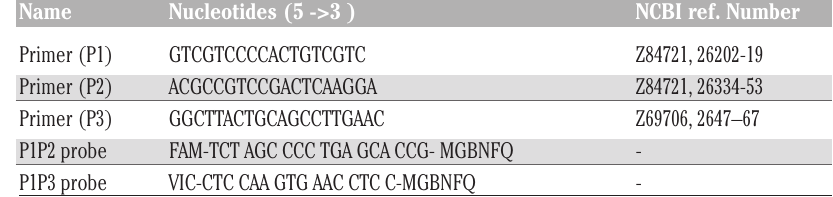
Table 1 Sequence and location of the ddPCR primers and Taqman probes.